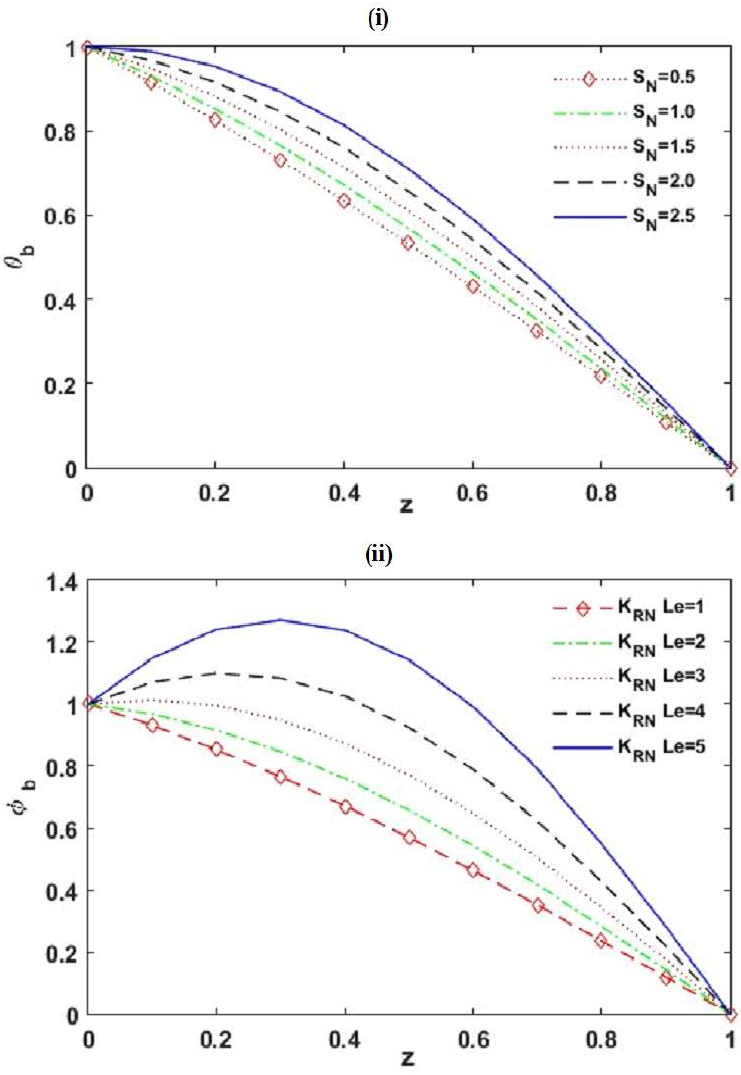
Figure 2. Distributions of basic state temperature ( Le ) and solute concentration ( (cid:101) φ b ) with the depth of Maxwell fluid layer (cid:101) z .